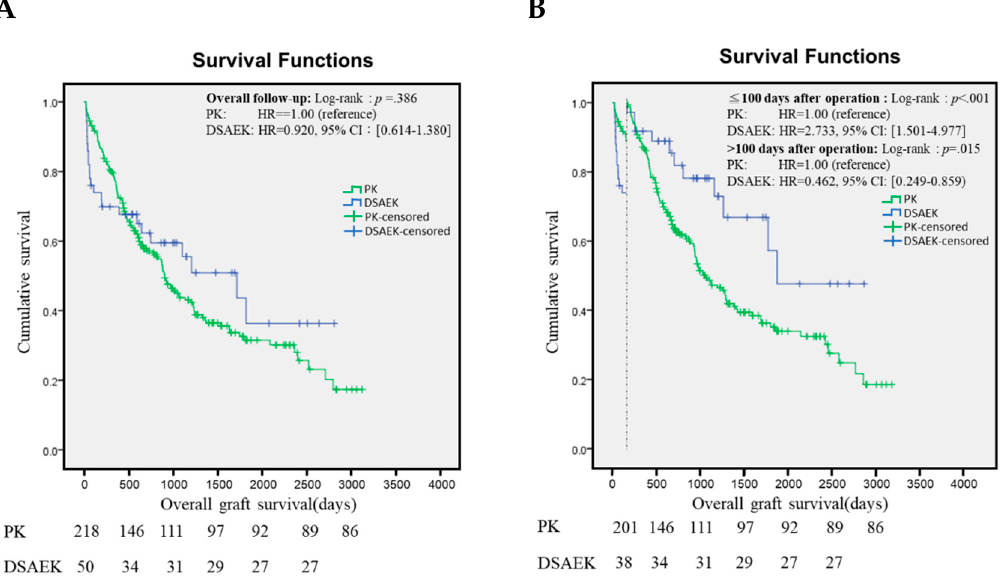
Figure 1. PK and DSAEK graft survival . ( A) Long-term survival analysis of PK (green) and DSAEK (blue). ( B ) Cox proportional regression analysis stratified by 100 days follow-up. PK = penetrating keratoplasty. DSAEK = Descemet stripping automated endothelial keratoplasty. HR = hazard ration. CI= confidence interval.